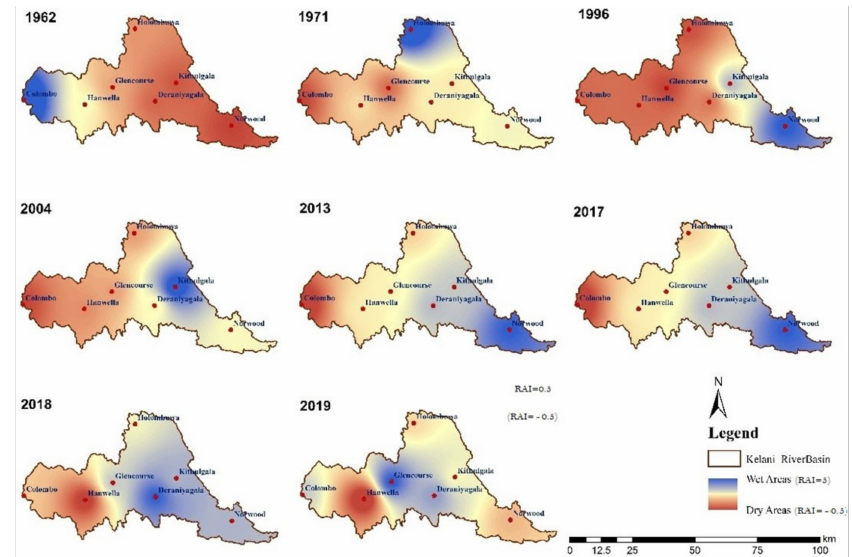
Figure 5. Spatial variability of annual RAI for the selected years (years with the highest spatial variability of RAI were selected for mapping).